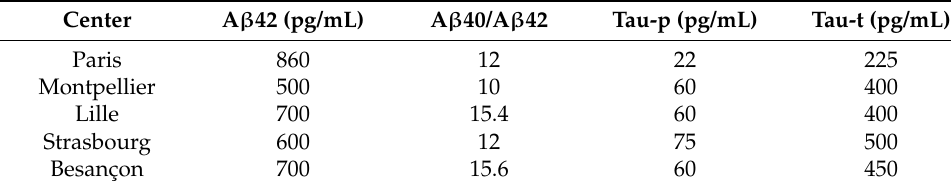
Table 1. Alzheimer’s disease biomarkers thresholds for each center.